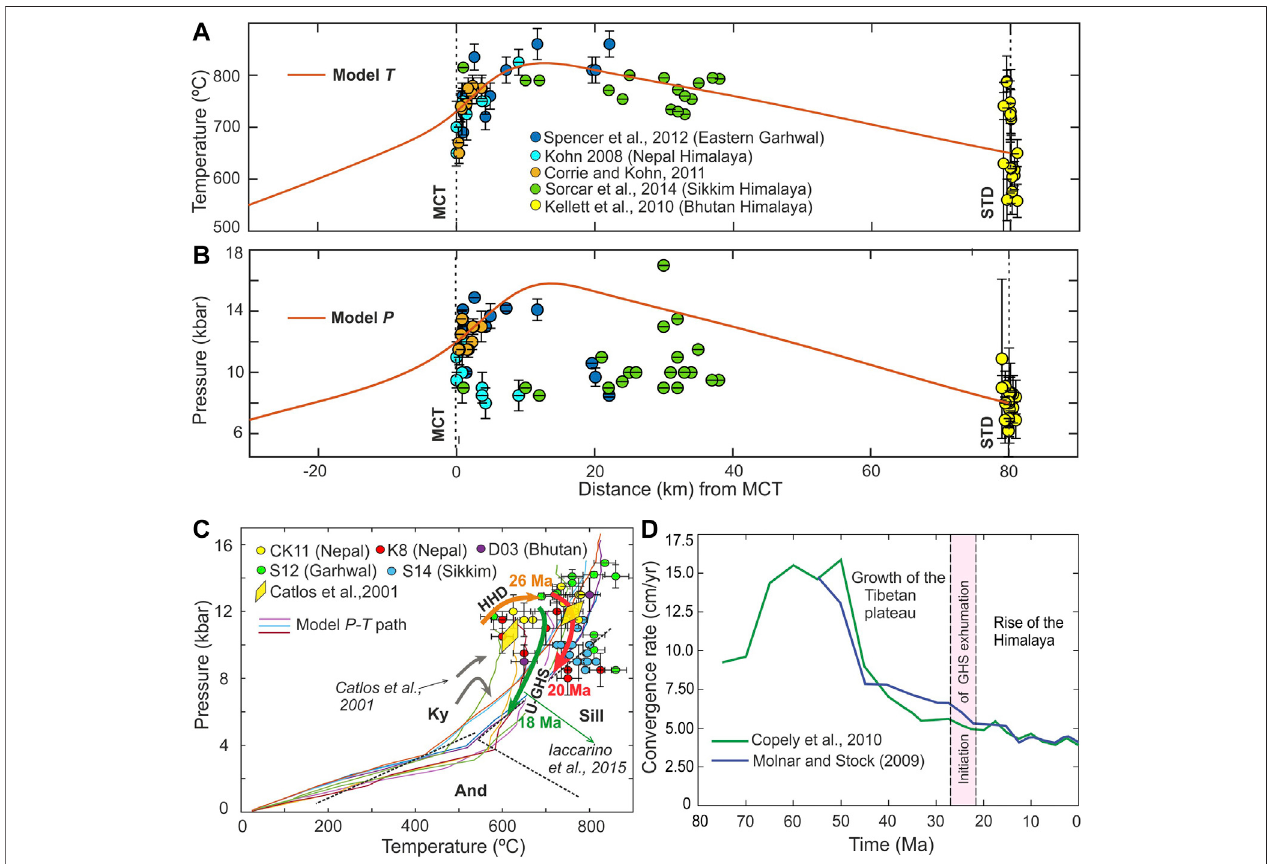
FIGURE 9 | Spatial variations of model (A) temperature and (B) pressure (orange lines) calculated from exhumed particles, initially located at different positions within the extrusion zone. The model estimates are compared with the petrological data (circles with error bar) reported from different regions of the Himalaya. (C) Comparison between model and petrological peak P-T-t data. Bold colored lines indicate exhumed P - T paths of several Lagrangian particles. The black dashed lines show the stability fi eld of kyanite (Ky), andalusite (And), and sillimanite (Sill) aluminosilicate phases (Abbreviations CK11: Corrie and Kohn, 2011; K8: Kohn, 2008; D03:Danieletal.,2003;S12:Spenceretal.,2012;S14:Sorcaretal.,2014). (D) VariationinIndia-Asiaconvergencevelocitywithtime.When u s ≥ 6 cm/yr(before27 Ma) there was major contractional deformation in the Tibetan plateau, which resulted in an increase of Tibetan plateau elevation. At u s ≤ 5 cm/yr (after 22 Ma) the plateau started to collapse, while Himalaya began to rise at its southern